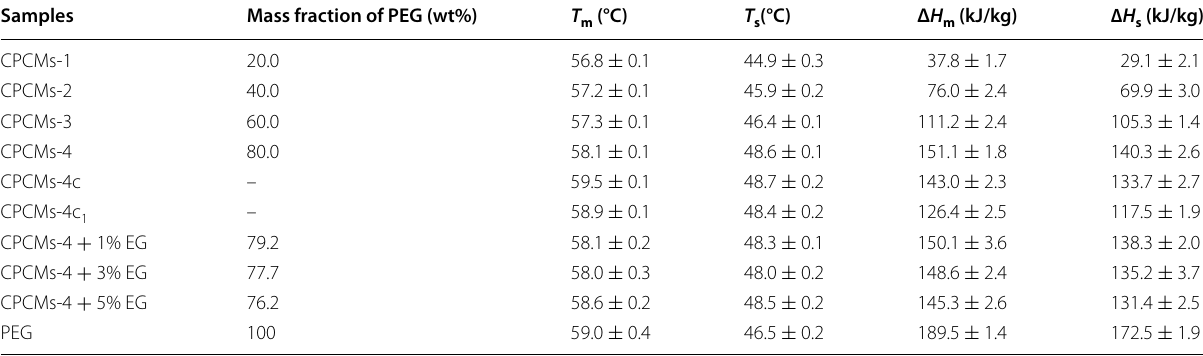
Table 3 Thermal characteristics of CPCMs-1, CPCMs-2, CPCMs-3, CPCMs-4, CPCMs-4c, CPCMs-4c CPCMs-4 with 3% EG, CPCMs-4 with 5% EG and